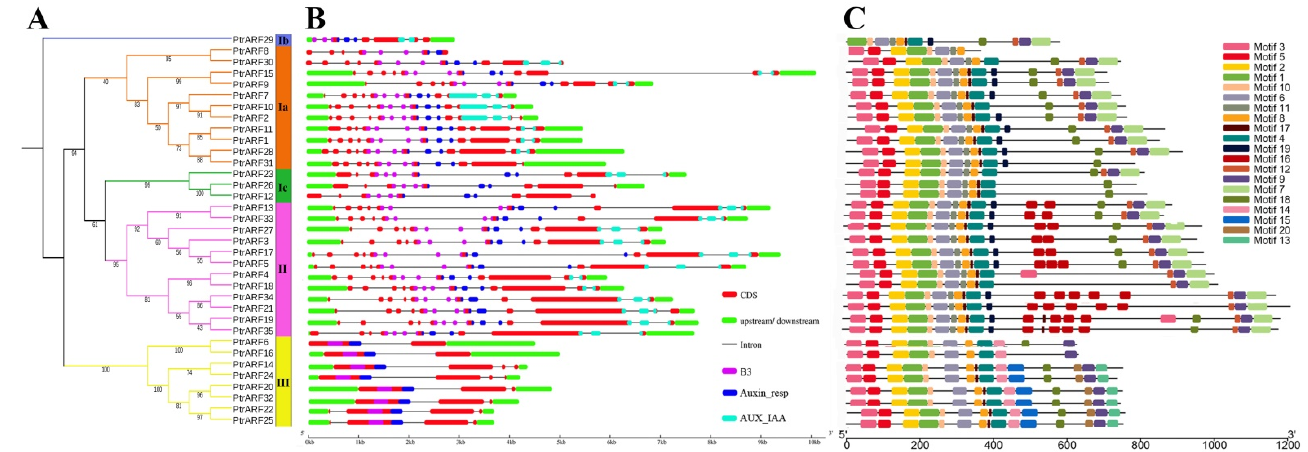
Figure 4. Phylogenetic tree, gene structures, and protein motifs of 35 PtrARF genes. ( A ) The phylogenetic tree. PtrARF protein sequences were aligned with Clustal X 2.0, and the phylogenetic tree was constructed using the neighbor-joining method; ( B ) Gene structures. Red boxes represent CDS regions, green boxes represent 5 ′ UTR or 3 ′ UTR regions, and black lines represent introns regions. The BD domains are indicated by purple boxes, the Auxin_resp domains are indicated by blue boxes, and the AUX_IAA domains are indicated by cyan boxes. The sizes of the exons and introns are estimated using the scale at the bottom; ( C ) protein motifs. The motif logos were drawn using Tbtools. Conserved motifs (1–20) are represented by different colored boxes, while non-conserved sequences are shown by black lines.